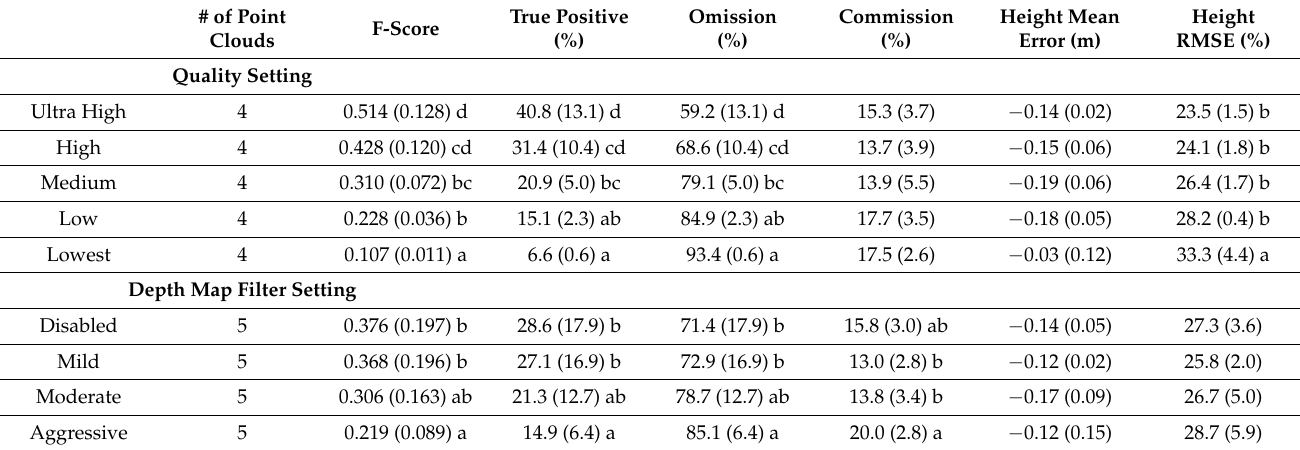
Table 4. Influence of Metashape build dense cloud Quality and depth map filter settings on the mean (standard deviation) of understory tree F-score and true positive, omission, commission rates. Letters represent significant differences ( α = 0.05) determined by two-way ANOVA with Tukey’s HSD